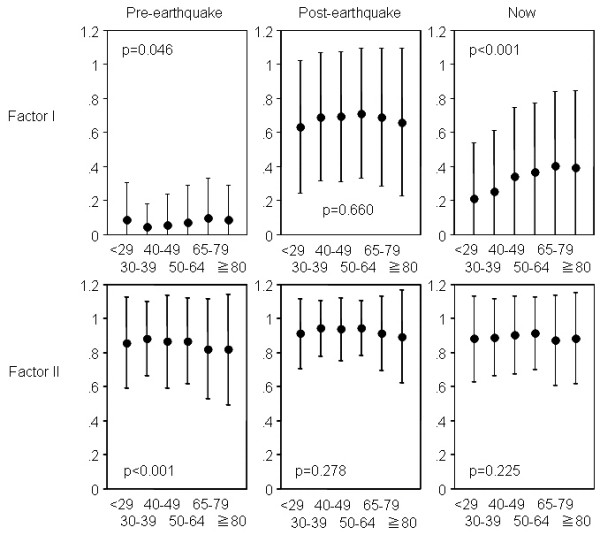
Differences in lower scale points of each factor by age group of subjects. The relationships between subjects' age and factor I or factor II points of pre-earthquake, post earthquake and now are shown as mean and standard deviation values. In each graph, plots from left to right correspond to the six groups of age shown in Table 1. Trends of GHQ-12 scores with increasing age of subjects were analyzed by the ANOVA. The p value in each test is shown in the plot.